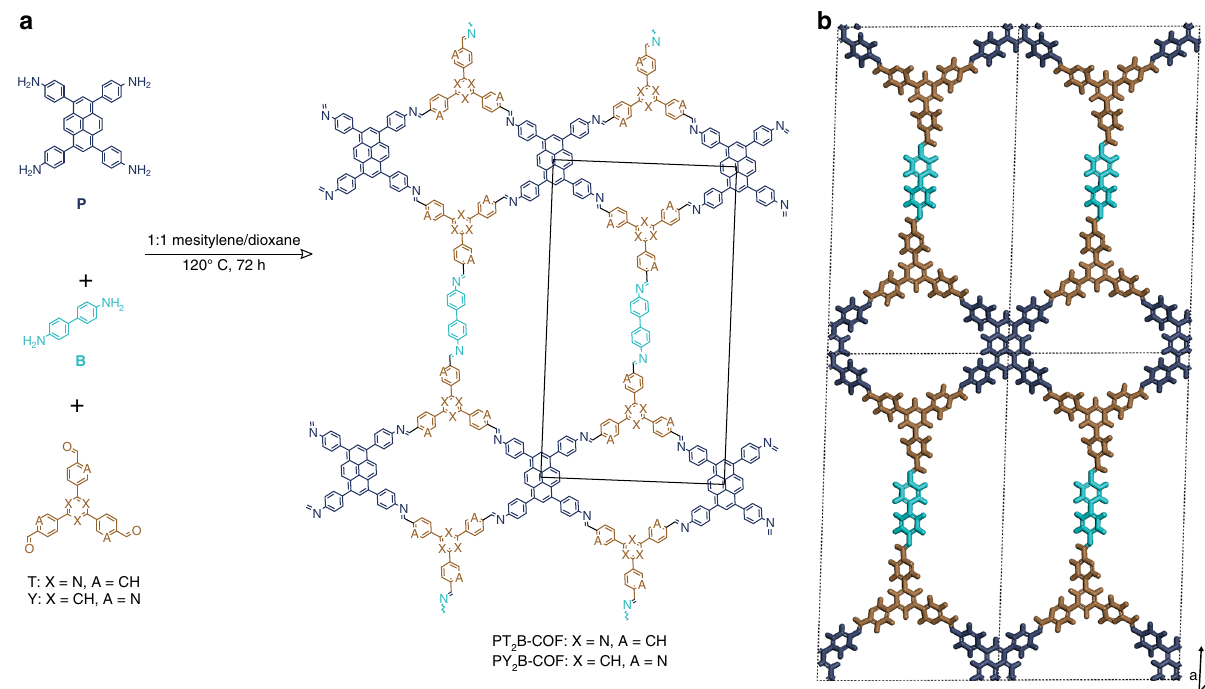
Fig. 4 Structure of PT 2 B- and PY 2 B-COFs. a Synthesis and molecular structure of PT 2 B- and PY 2 B-COFs. The in-plane unit cell is outlined in black. b Illustration of the COF structure model (viewed perpendicular to the ab